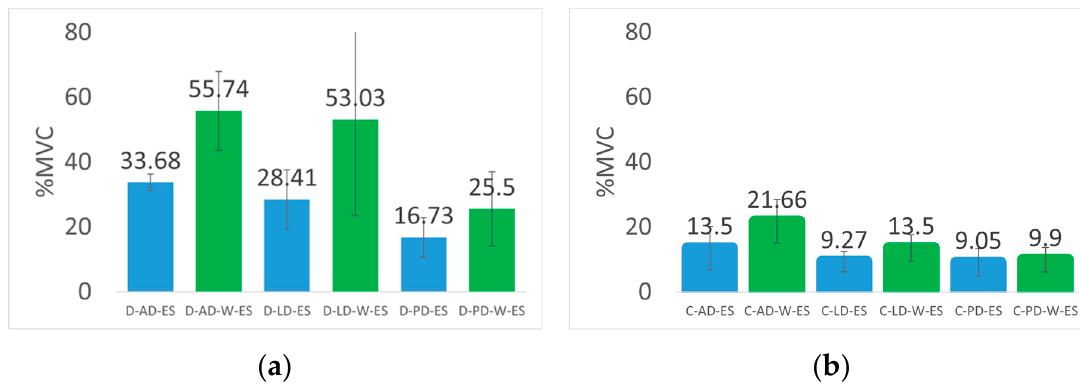
Figure 4. The %MVC of the AD, lateral deltoid (LD), and posterior deltoid (PD) for groups C and D with and without using the PULE for: ( a ) fruit thinning of the jujube tree; ( b ) pesticide spraying on the pomelo tree.